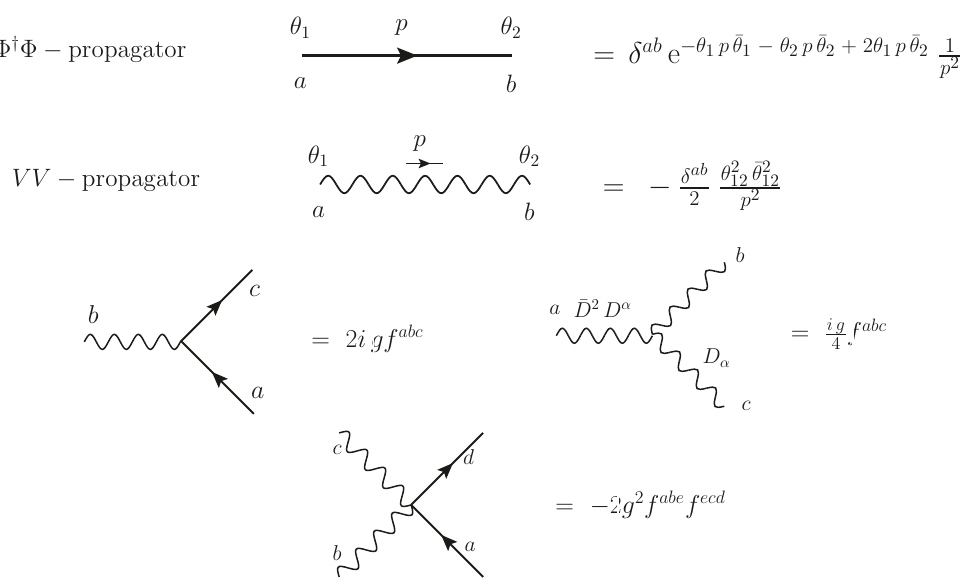
Figure 1 . Feynman rules for the gauge part of the